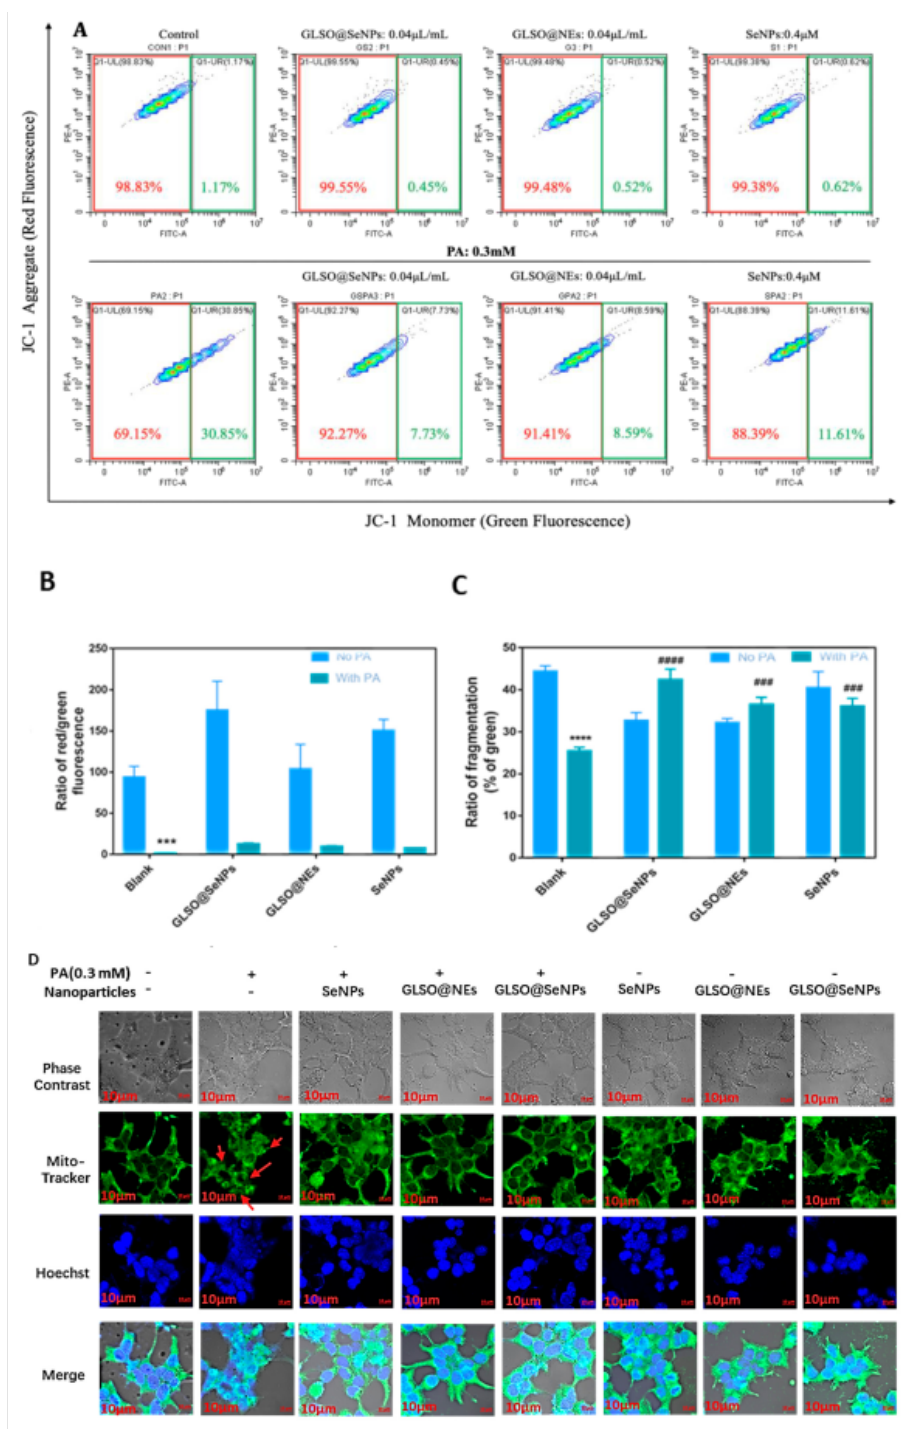
Figure 4. GLSO@SeNPs inhibit the PA-induced mitochondrial membrane potential decrease and fragmentation in INS-1E cells. ( A ) Distribution ratio of red and green fluorescence in INS-1E cells. (Red fluorescence refers to the JC-1 probe existing in the mitochondria of normal cells in the red polymer state, and green fluorescence refers to the JC-1 probe diffused from the mitochondria of apoptotic cells in the form of green monomer) ( B ) Quantitative analysis of the ratio of red/green fluorescence in INS-1E cells. ( C ) Quantitative analysis of mitochondrial fragmentation by fluorescence image. (*** (###) p < 0.05 means high significance, **** (####) p < 0.05 means the highest significance.) ( D ) Fluorescence images of mitochondrial disruption in cells of each drug treatment